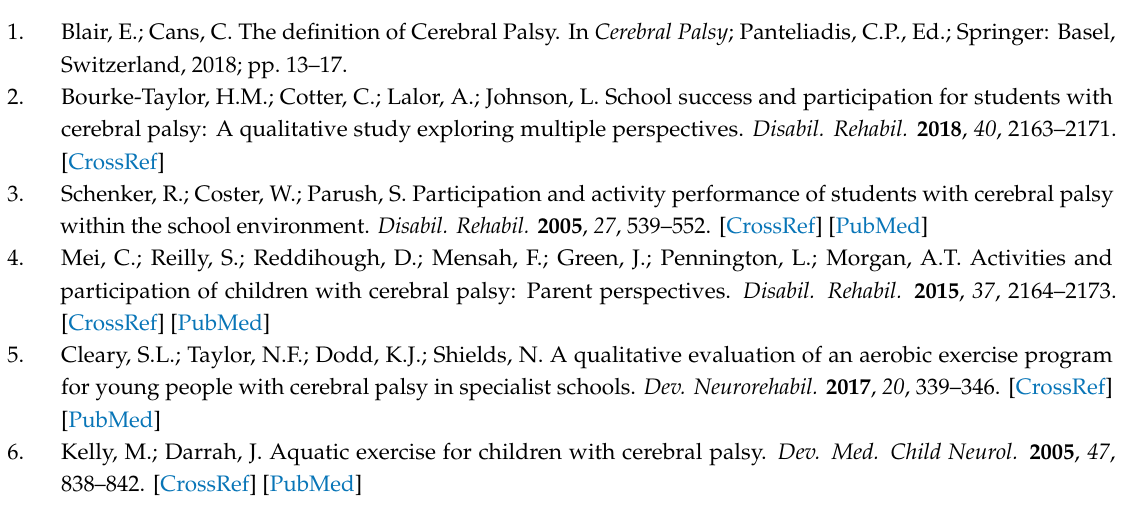
Table S1: Questions for children; Table S2: Questions for parents; Table S3: Questions for